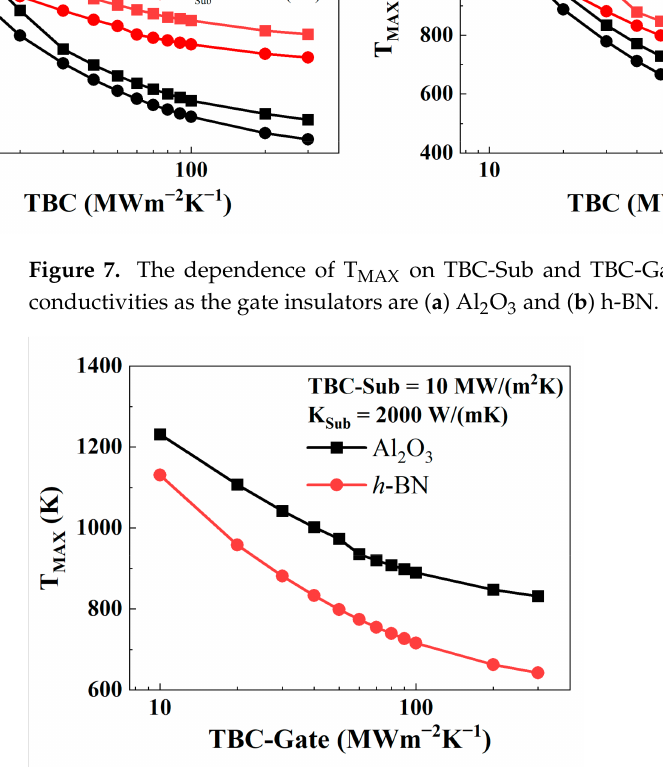
Figure 8. The dependence of T MAX on TBC-Gate for different gate insulators.